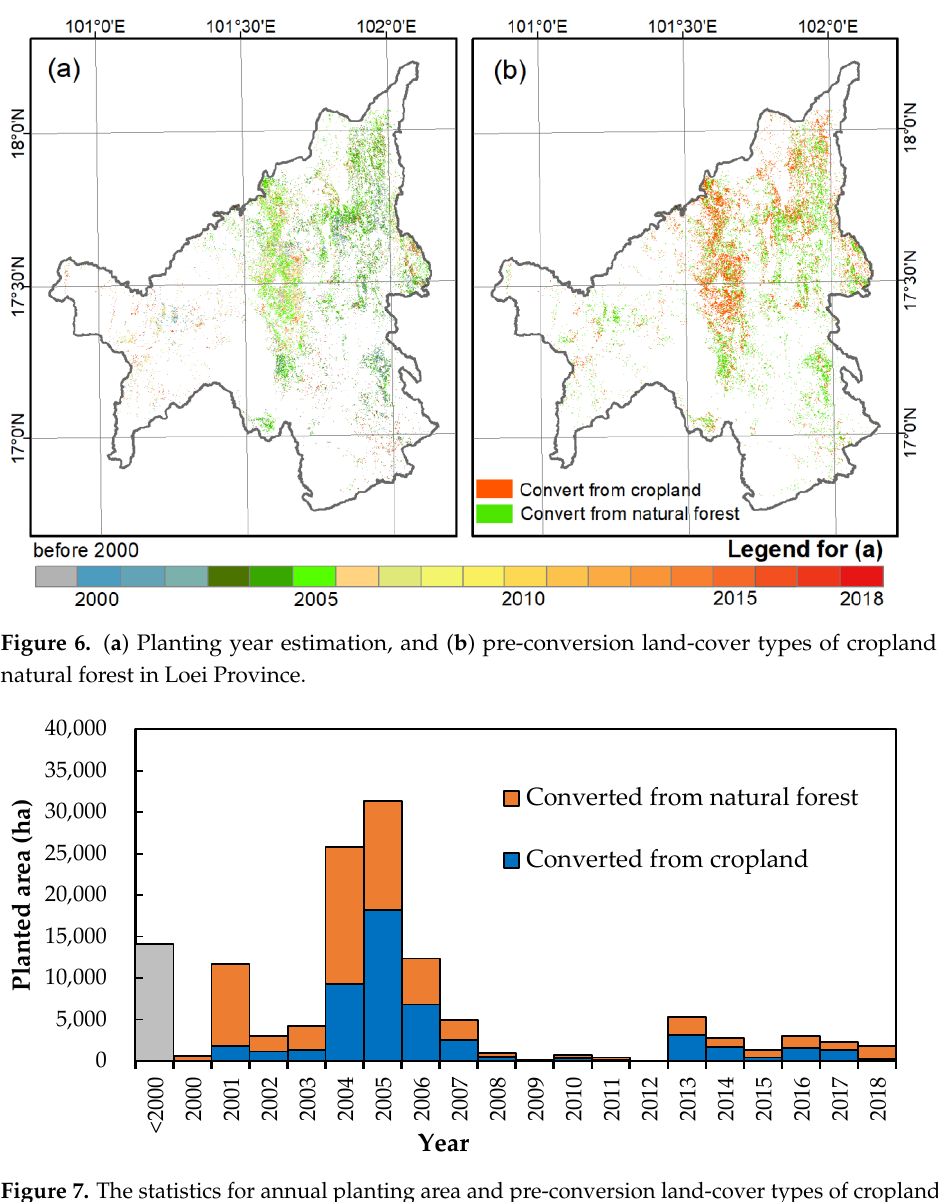
Figure 7. The statistics for annual planting area and pre-conversion land-cover types of cropland and natural forest in Loei Province for each year. Year < “2000” indicates rubber planted before 2000.